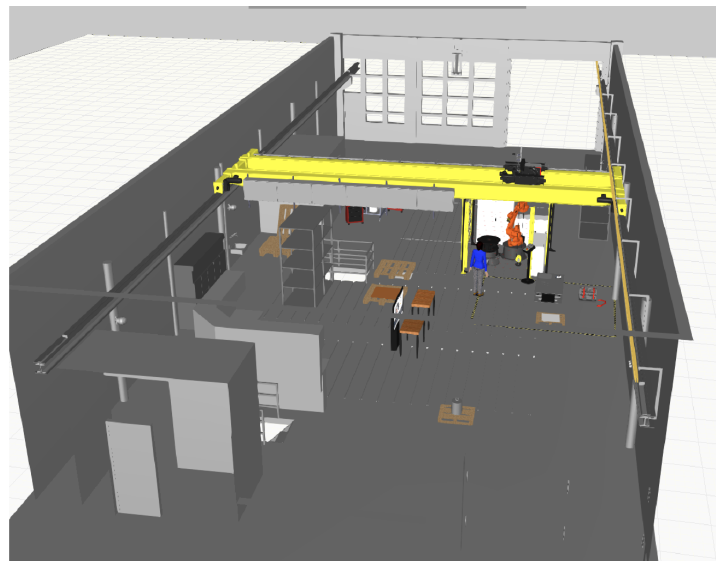
Figure 3. Layout of the lab AIIC environment with the crane inside (a screen capture of a Visual Component model